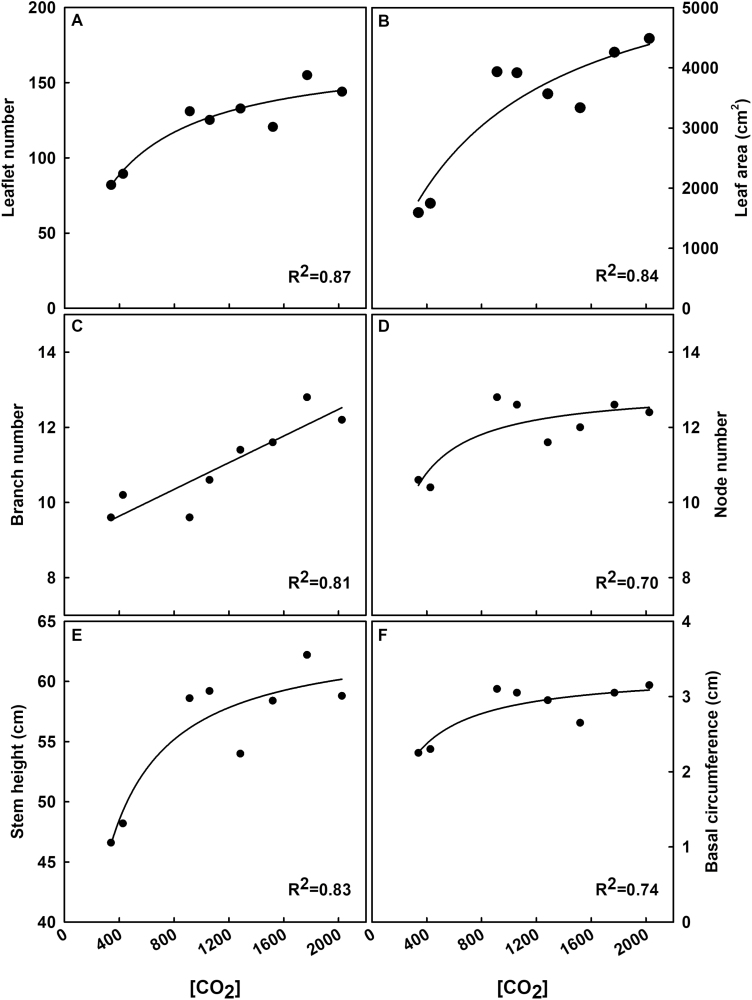
Plant traits from final harvest as a function of [CO2]. Parameters include mean (A) leaflet number, (B) leaf area, (C) branch number, (D) node number, (E) stem height, and (F) basal stem circumference. Each point represents the plant-level average from each treatment. Statistically significant relationships (P<0.1) as a function of [CO2] are indicated by a fit plotted through the data. R2 values are indicated in the figure.